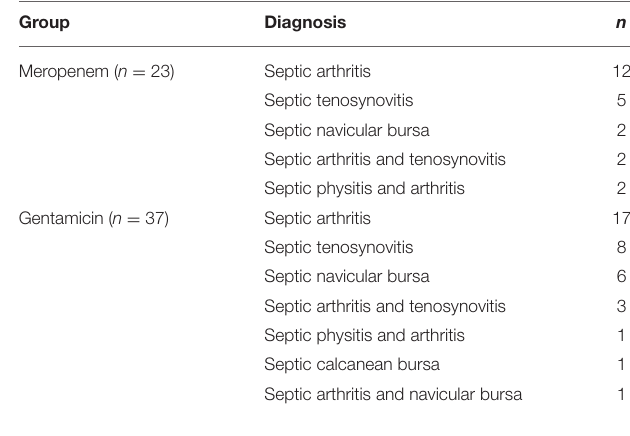
TABLE 2 | Diagnoses for horses administered either meropenem or gentamicin via intravenous regional limb perfusion (IVRLP).